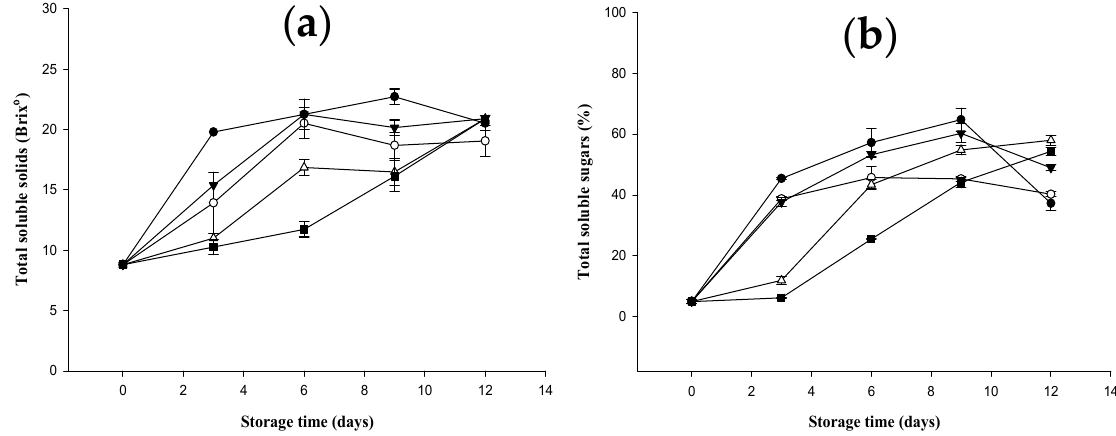
Figure 2. Effect on ( a ) weight loss, ( b ) firmness, ( c ) pH, and ( d ) titratable acidity (triplicate mean ± SD) of bananas coated with different concentrations of D-limonene nanoemulsion edible film and